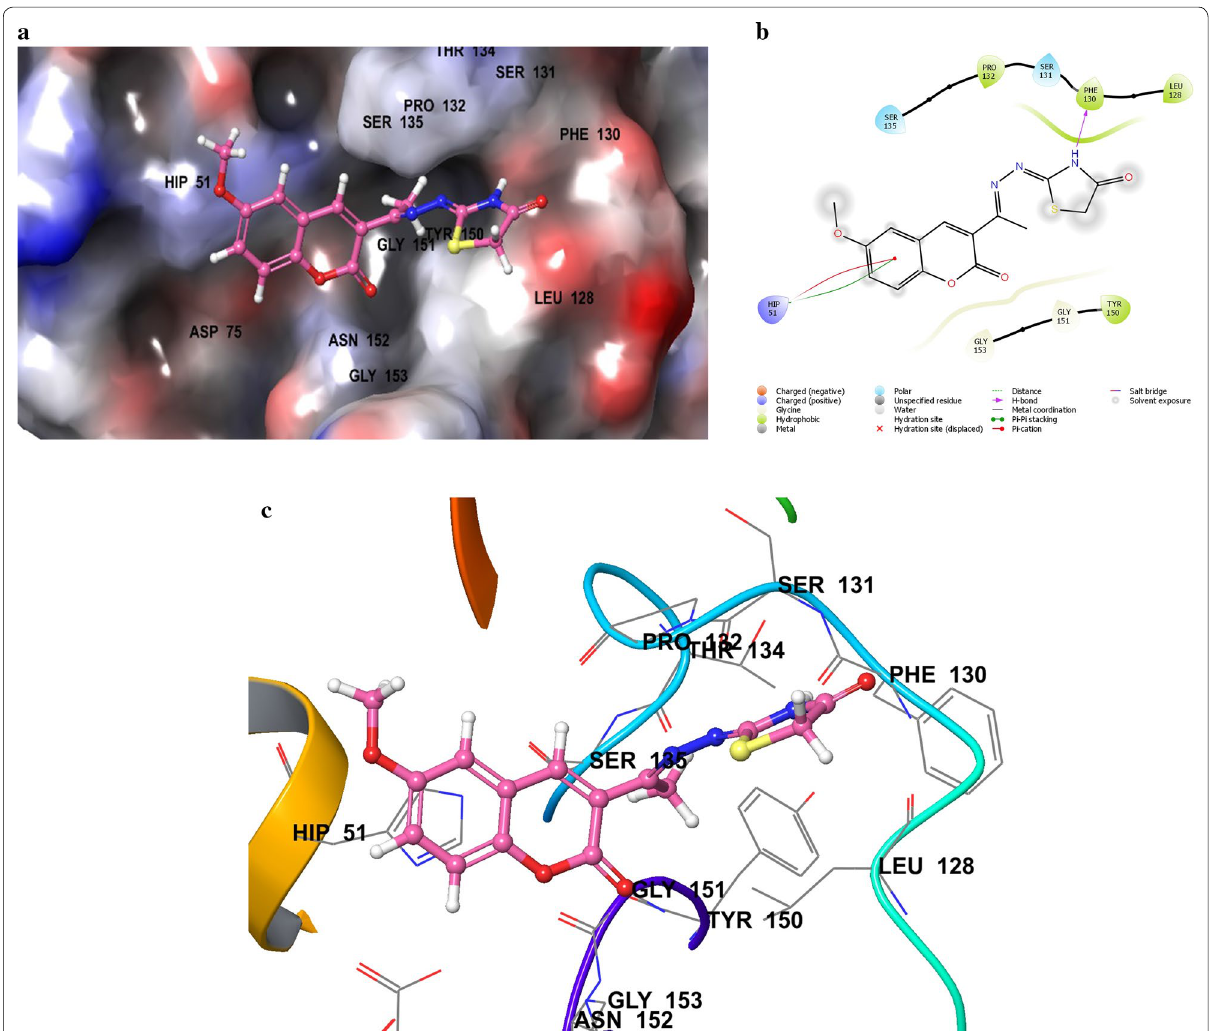
Fig. 7 Binding modes of compound SKYd with dengue virus NS2B/NS3 protease: a Protein as surface and compound as sticks; b Protein and compound as 2D interaction image; c Protein as ribbon and compound as